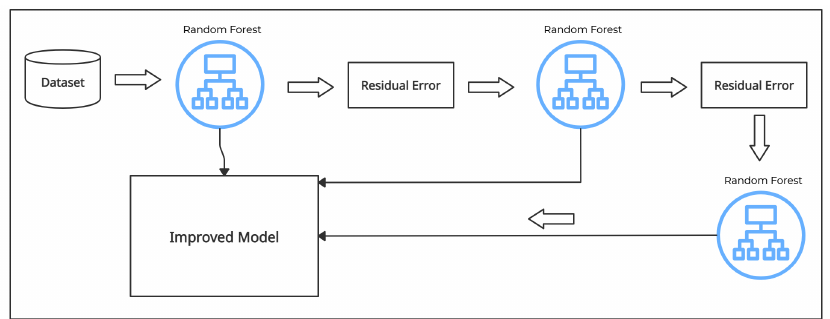
Figure 8. Schematic diagram of Gradient Boost Decision Tree (GBDT)